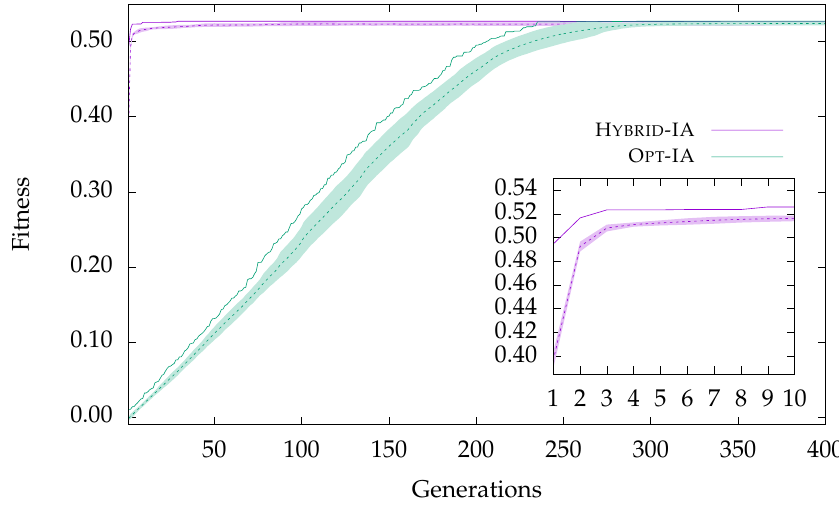
Figure 1. Convergence behaviour of O PT -IA and H YBRID -IA on the Books about US Politics network.